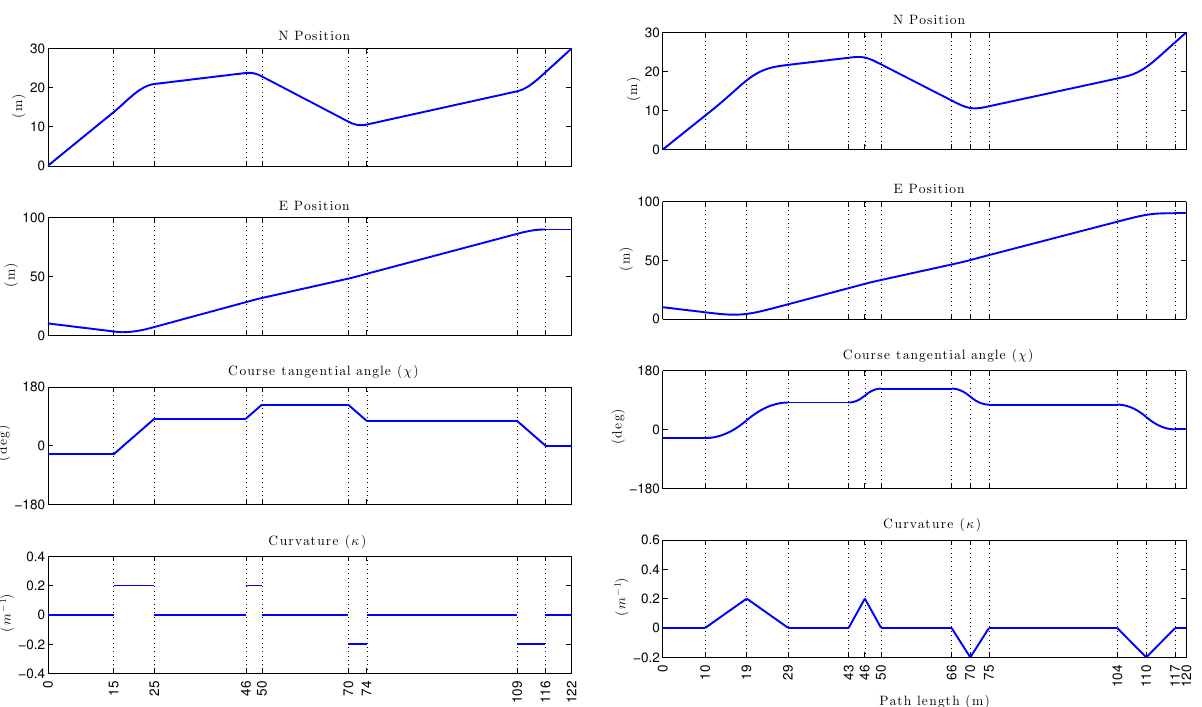
Figure 6: Clothoid smoothing path geometric proper-